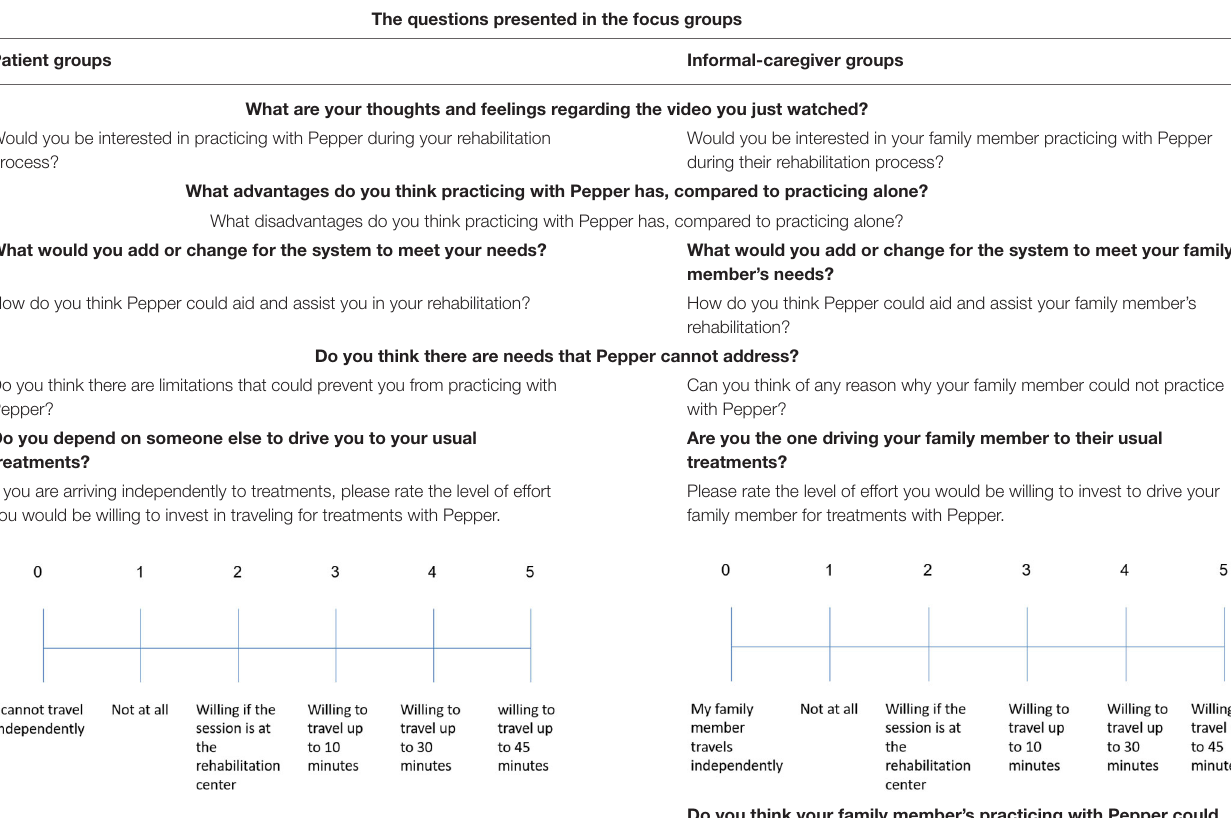
TABLE 1 | Discussion questions - Patient groups and Informal-caregiver groups.